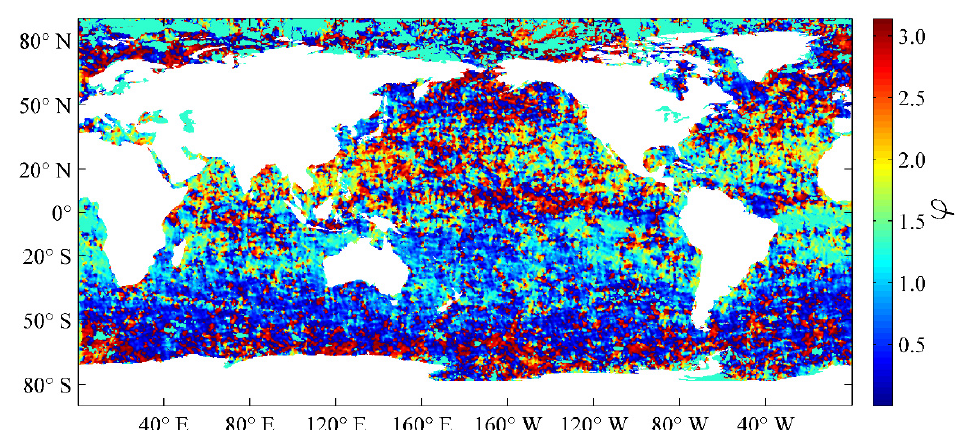
Figure 3. Global distribution of the ϕ parameter estimated using the optimum interpolation (OI) analysis results of 2015 [13].